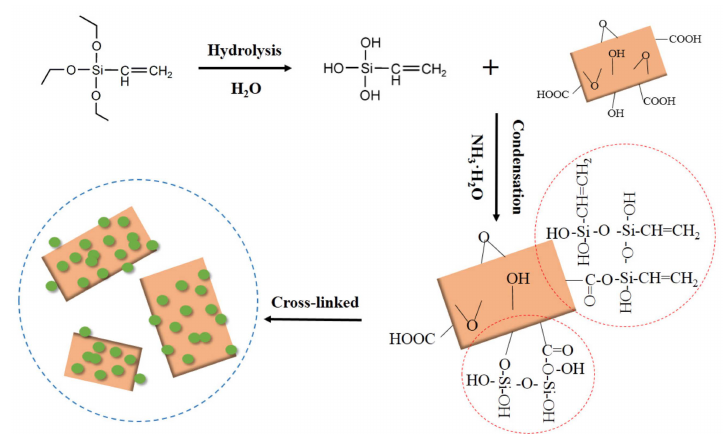
Scheme 2. The schematic diagram of the reaction mechanism of synthesizing silane functionalized graphene.